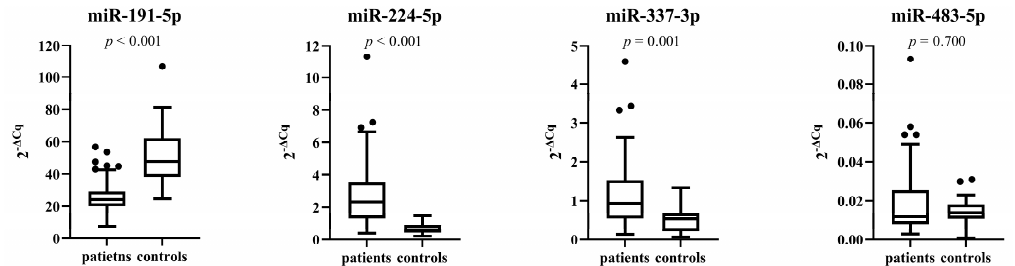
Figure 2. Comparison of miRNAs expression between patients and control subjects.